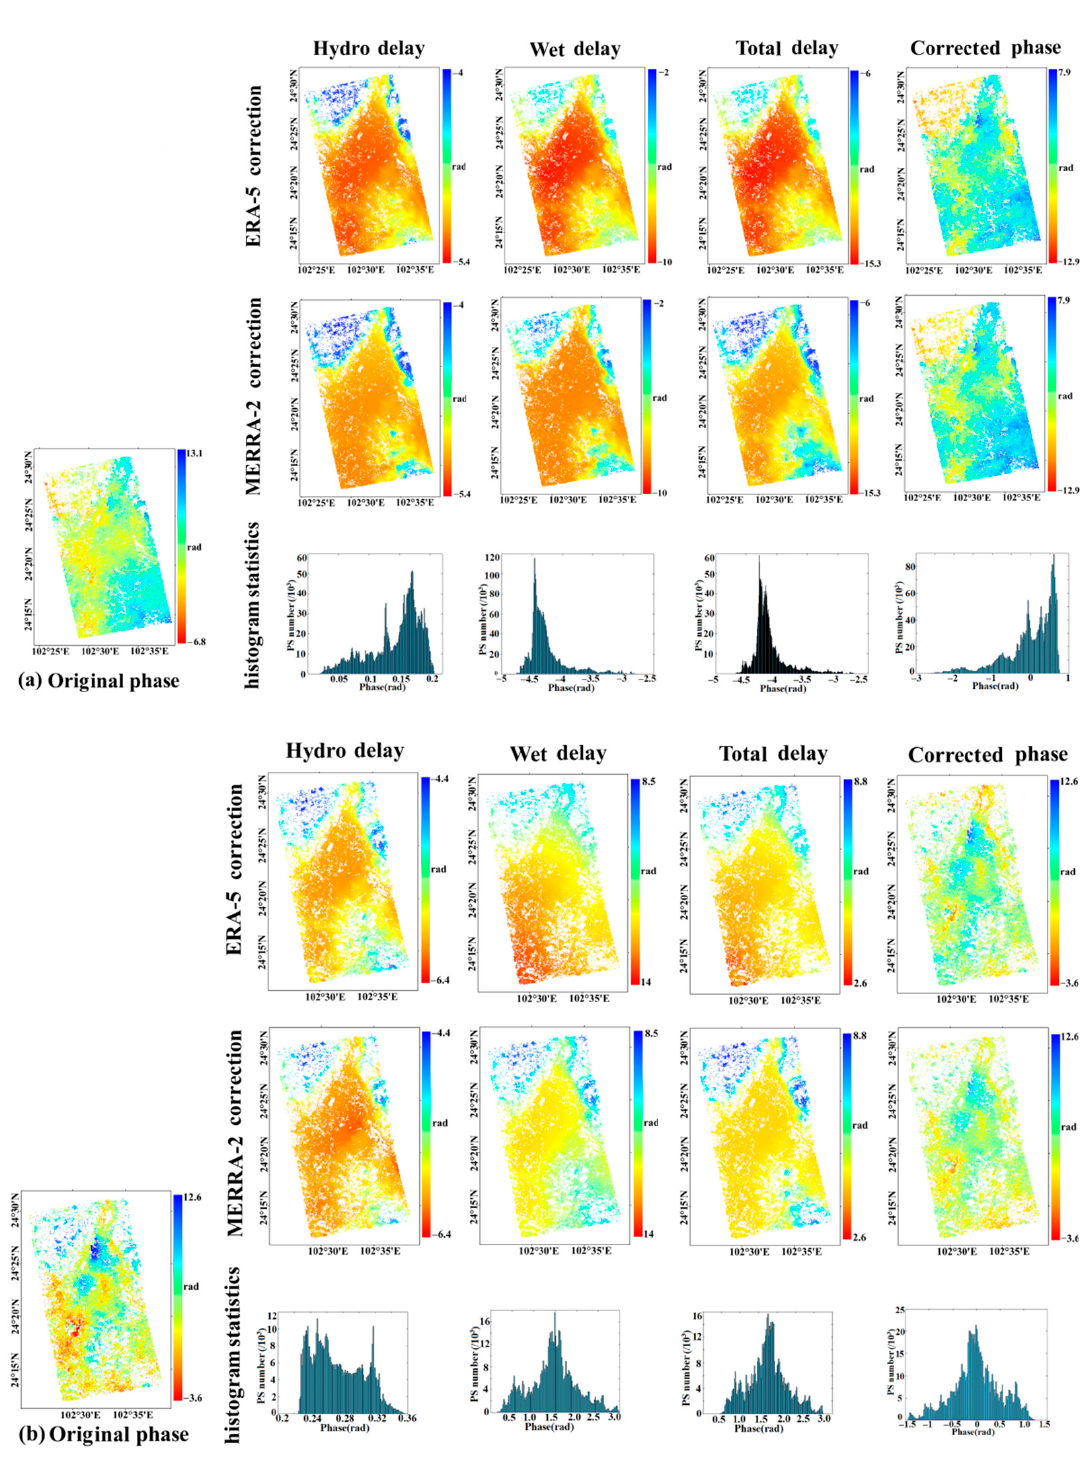
Figure 4. Comparison of the atmospheric delay correction effects in Sentinel-1A and Radarsat-2. ( a ) Two types of meteorological reanalysis data were used to correct the atmospheric delay in Radarsat-